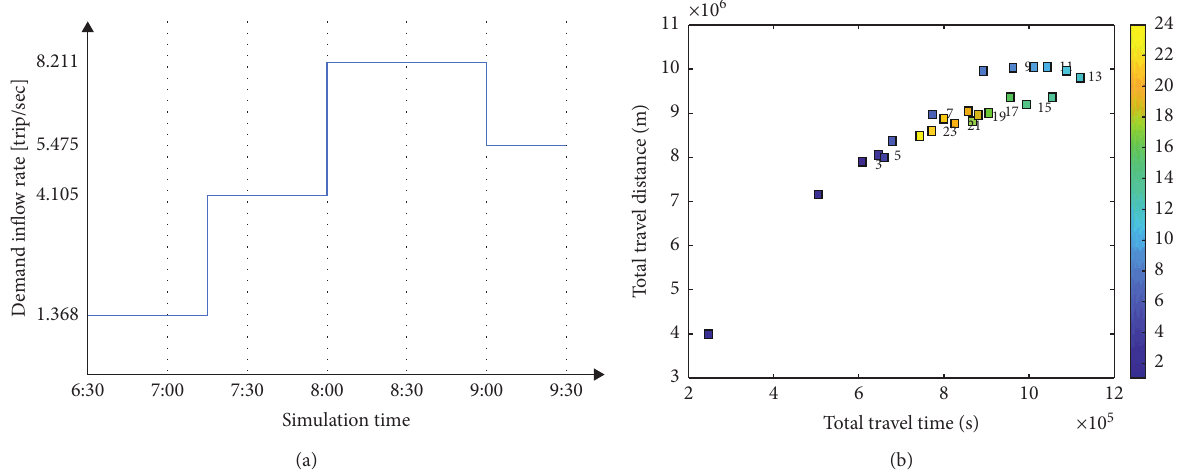
Figure 3: The demand scenario of Lyon 6th+Villeurbanne. (a) The demand profile. (b) The macroscopic fundamental diagram from 7: 00 to 9 :00.